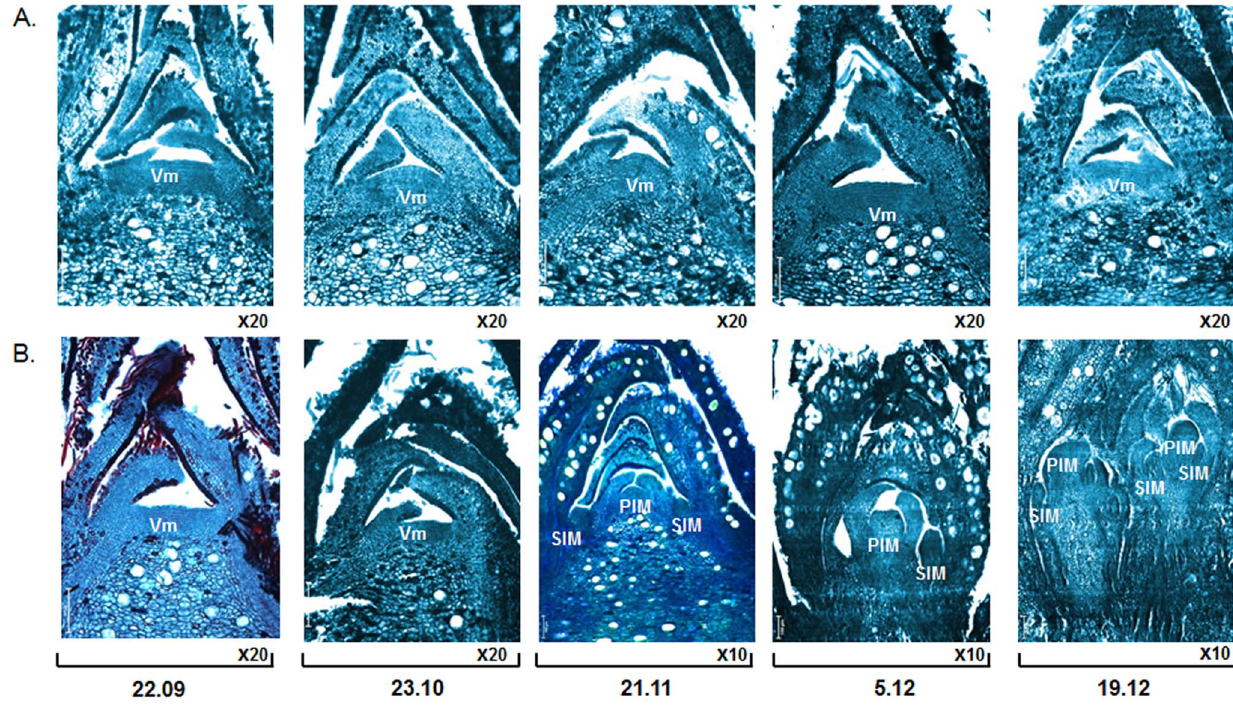
Figure 9. Successive microscopic views of apical buds. Successive microscopic views of apical buds were collected at different times from on (A) and off (B) trees. Off trees correspond to trees from which fruit load was completely removed in July. Abbreviations: VM, vegetative meristem; PIM, primary inflorescence meristem; SIM, secondary inflorescence meristem.